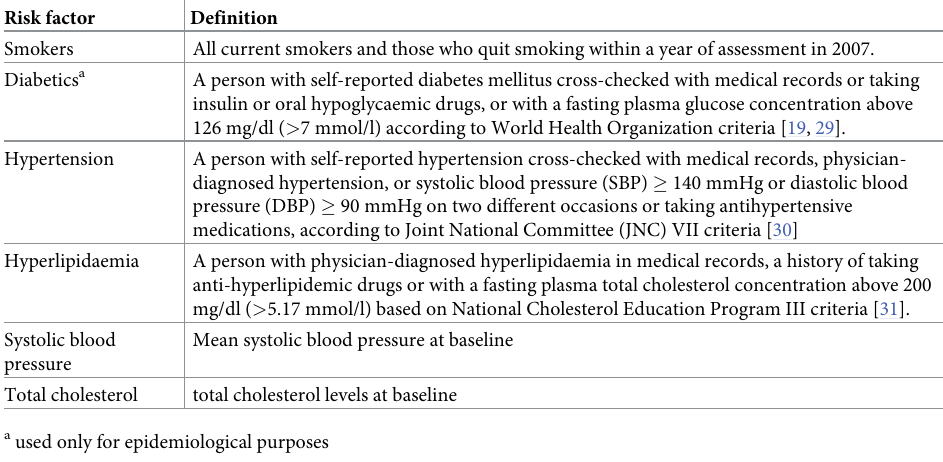
Table 1. Definitions of risk factors used in 10-year cardiovascular risk predictions